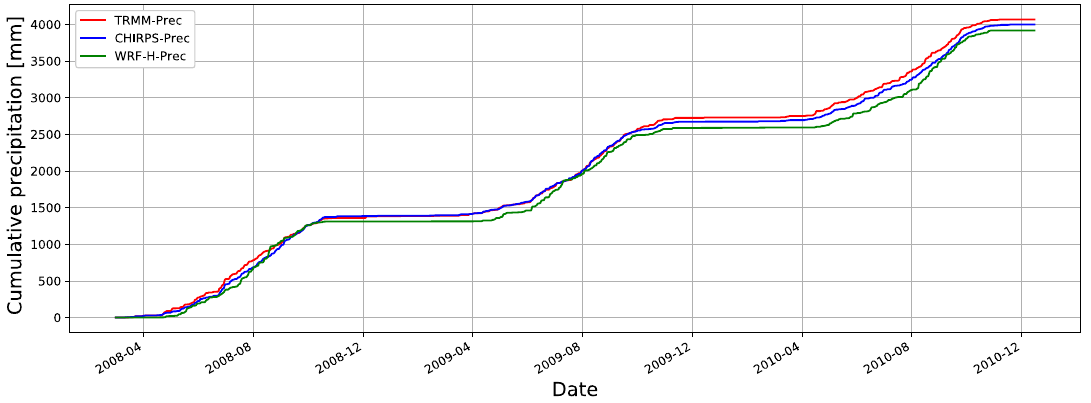
Figure 8. The cumulative total precipitation derived from TRMM and CHIRPS, and simulated in WRF-H over Bétérou during the period 2008–2010.